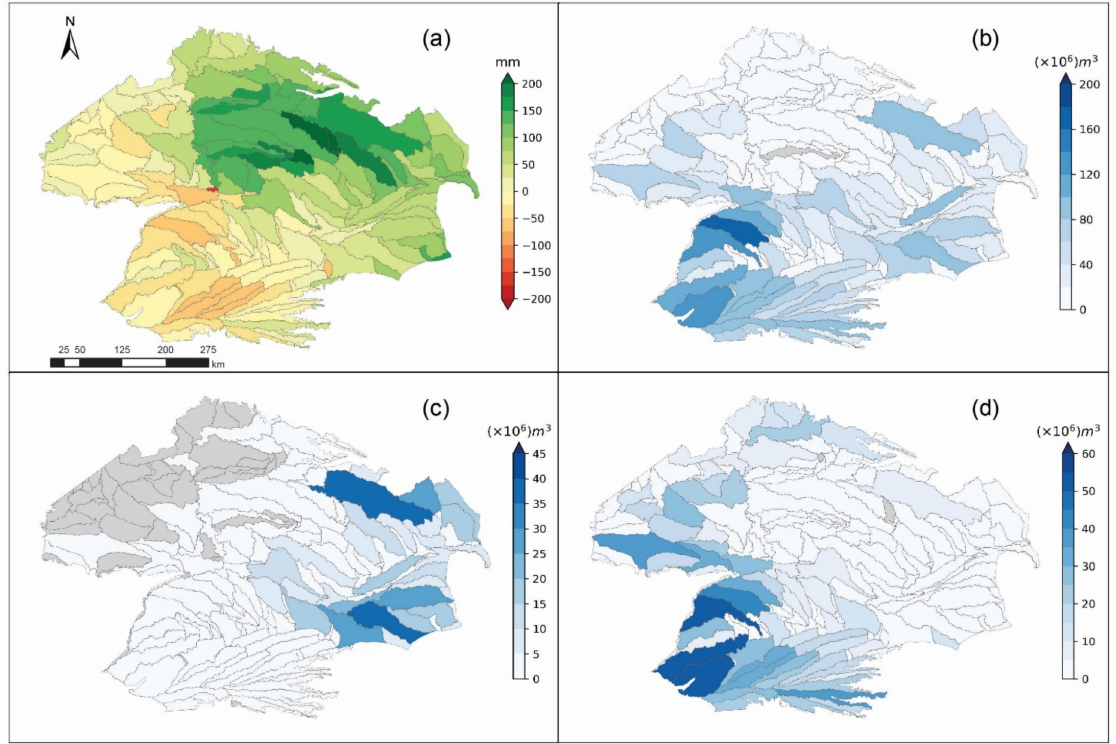
Figure 9. Simulated mean annual ( a ) difference in precipitation and evapotranspiration, ( b ) corn irrigation volume, ( c ) soybean irrigation volume, and ( d ) winter wheat irrigation volume, at the sub-basin level from